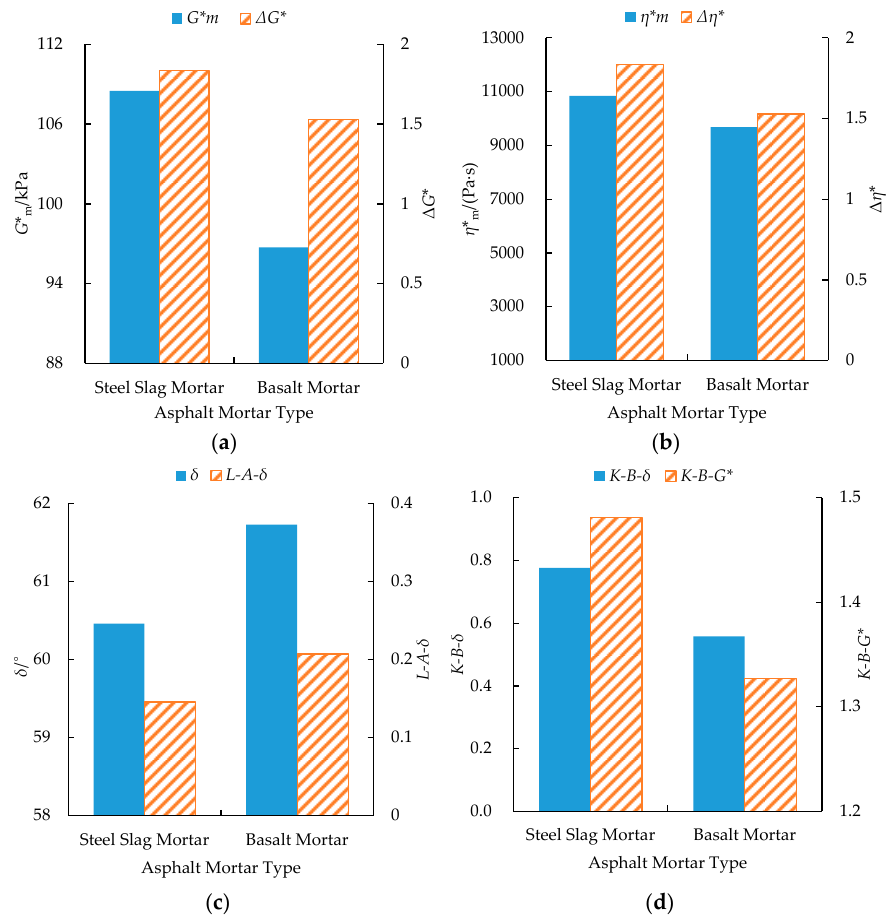
G ∗ and Δ G * indices; ( b ) m